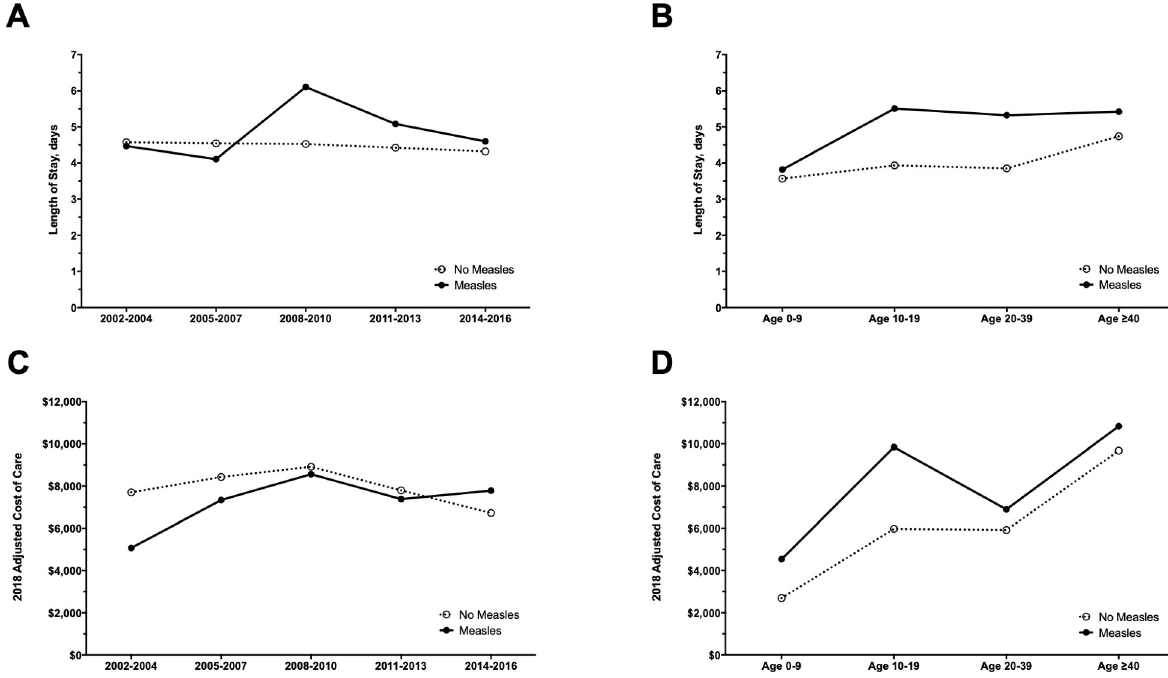
Fig 3. Length of stay and cost of care. Length of stay by year (A) and age (B) and cost of care by year (C) and age (D) for hospitalized patients with and without measles.